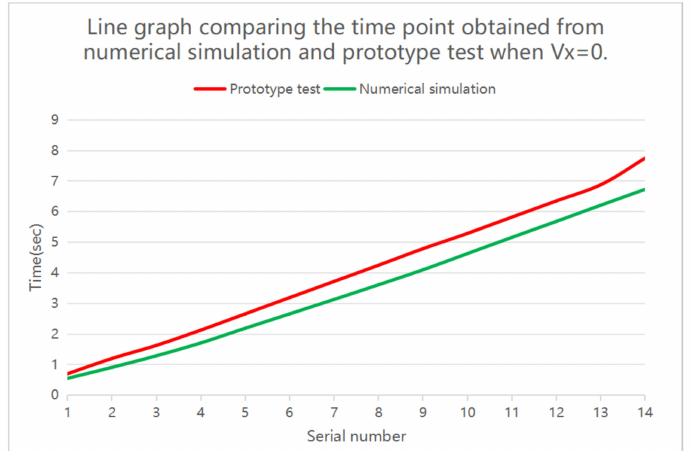
Figure 21. Line graph comparing the time point obtained from numerical simulation and prototype test when V x = 0. The x-axis represents serial number of the time point, and the y-axis denotes the time when the velocity of sphere becomes zero in the x-axis direction. The maximum absolute error of the 14 points is 1.02 s, with a relative error of 13%. The absolute error of other time points is below 0.67 s, which satisfies the requirements of the